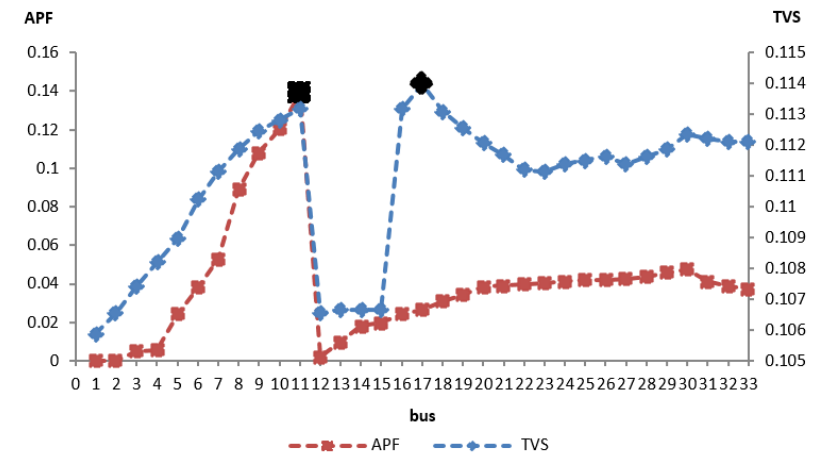
Figure 5. The APF and TVS for determining the third DER location.